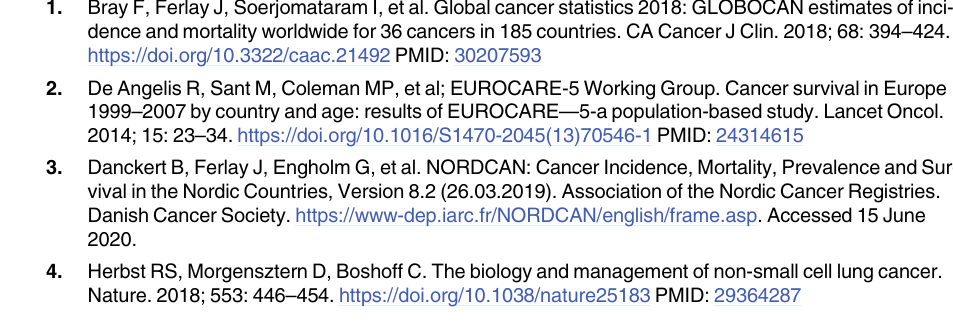
S2 Table. PD-L1 expression level by EGFR and KRAS mutation status in patients with stages II, and IIIA NSCLC receiving adjuvant